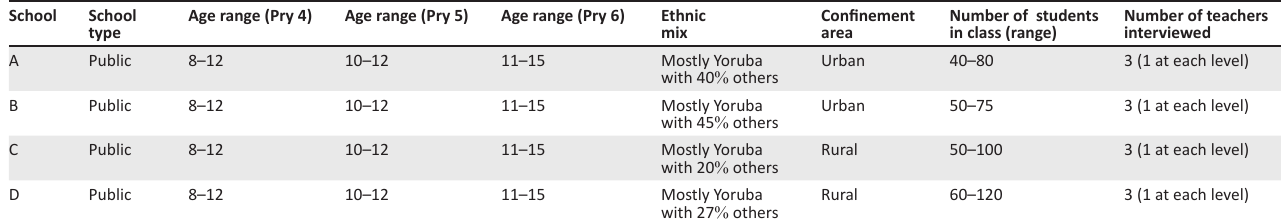
TABLE 2: Profiles of the